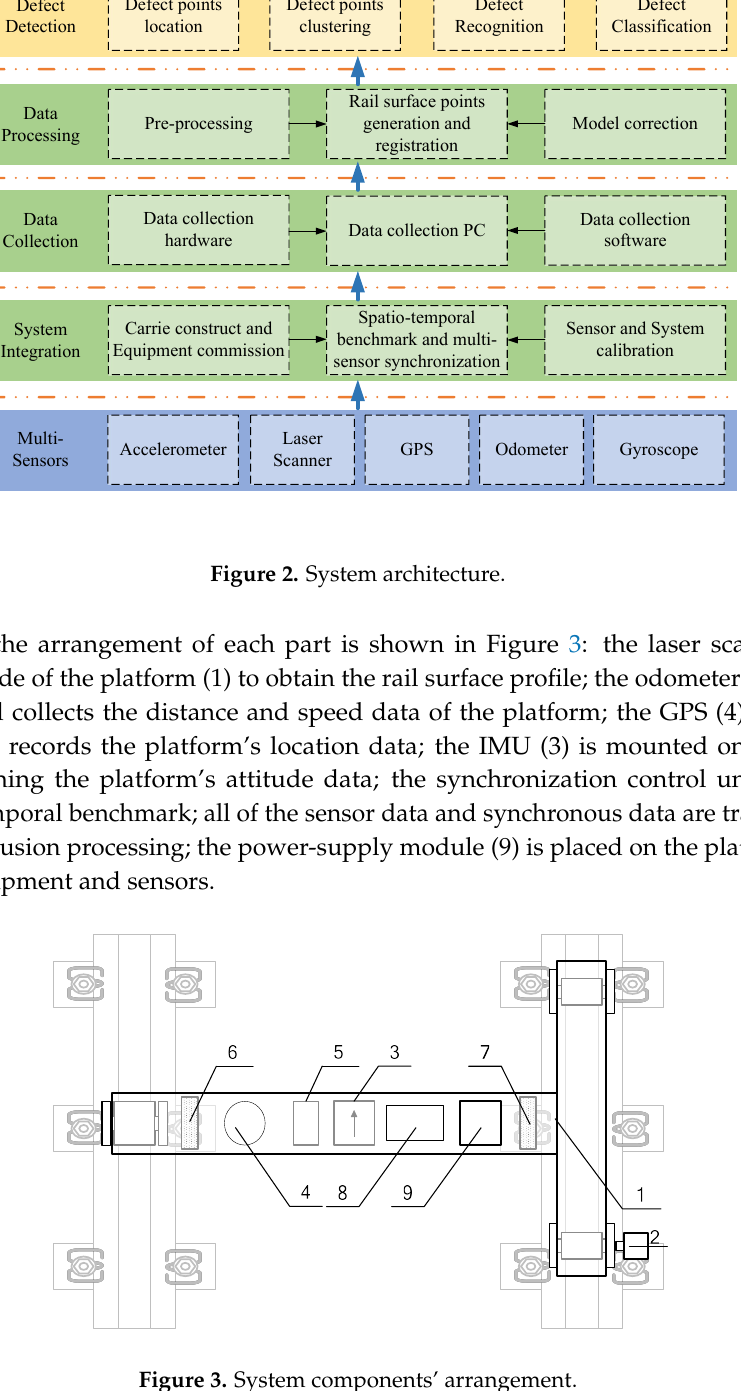
Figure 3. System components’